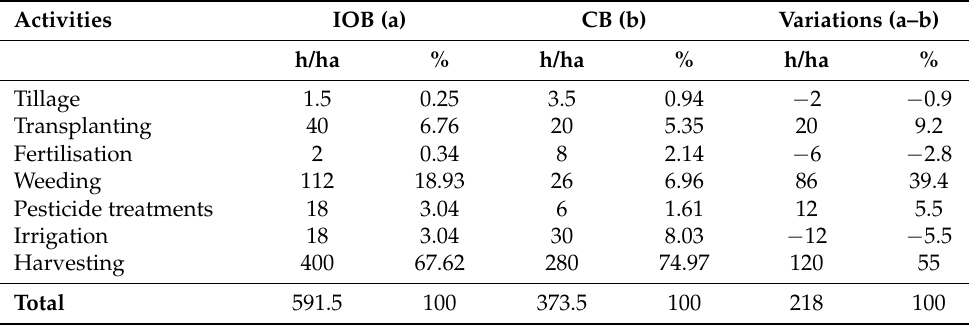
Table 4. The activity level of broccoli growing (*).